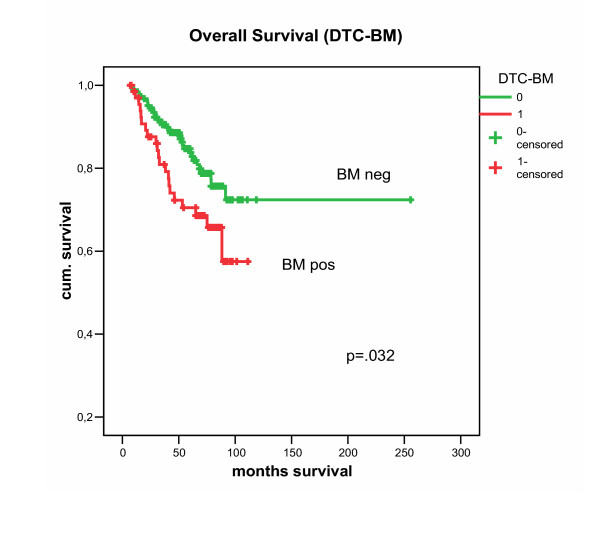
Correlation of overall survival with bone marrow (BM) status (Kaplan-Meier analysis, logrank-test). Cum, cumulative; DTC-BM = DTCs in bone marrow; neg, negative; pos, positive.